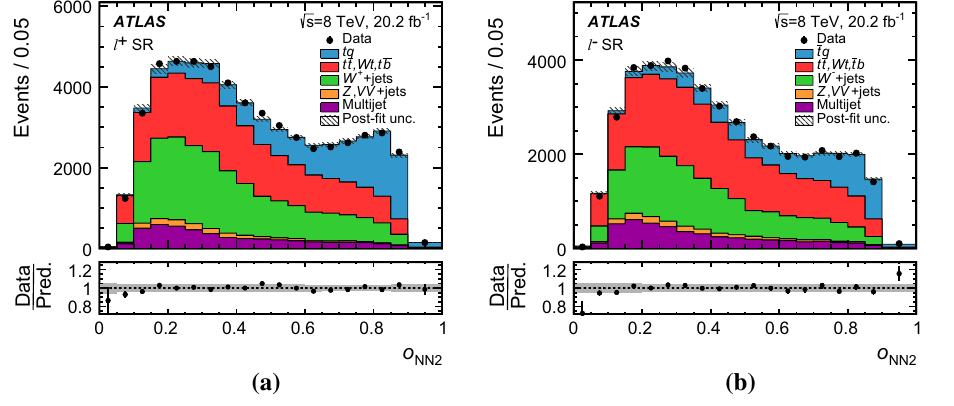
Fig. 13 Neural network output distribution ( O NN2 ) of the neural net- work without | η( j ) | normalised to the fit results of the default network for a the (cid:5) + and b the (cid:5) − signal region (SR). The distributions are compared to the model obtained from simulated events. The simulated